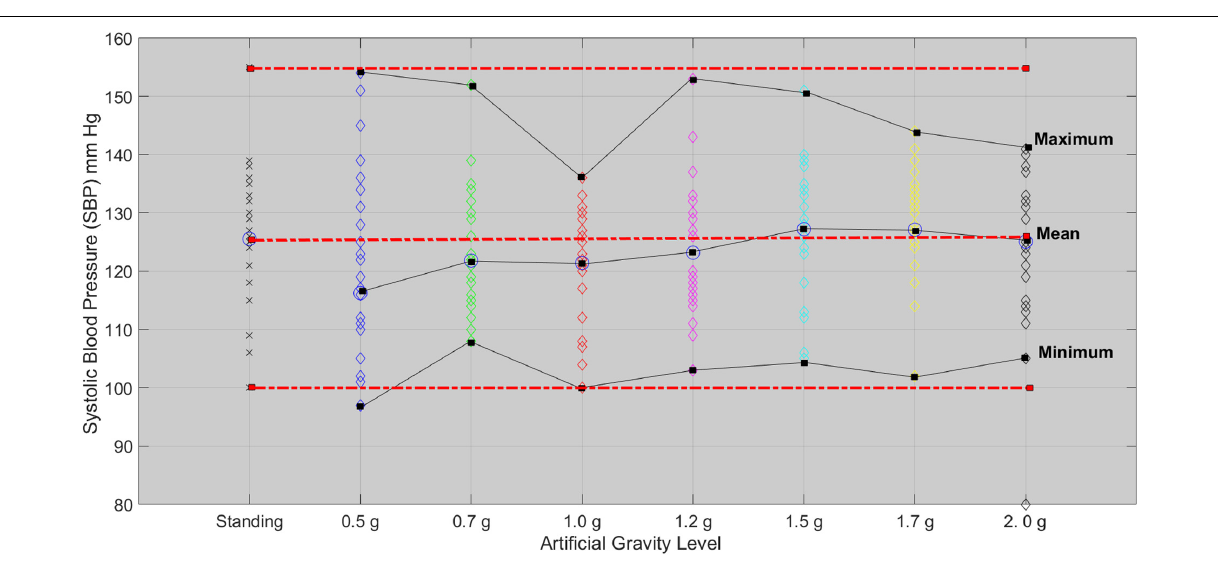
FIGURE 7 | Systolic blood pressure for each of the 24 participants in the standing position (red dotted line) and at each artificial gravity (AG) load (denoted with a diamond of a different color: blue, 0.5g; green, 0.7g; red, 1.0g; magenta, 1.2g; cyan, 1.5g; yellow, 1.7g; black,